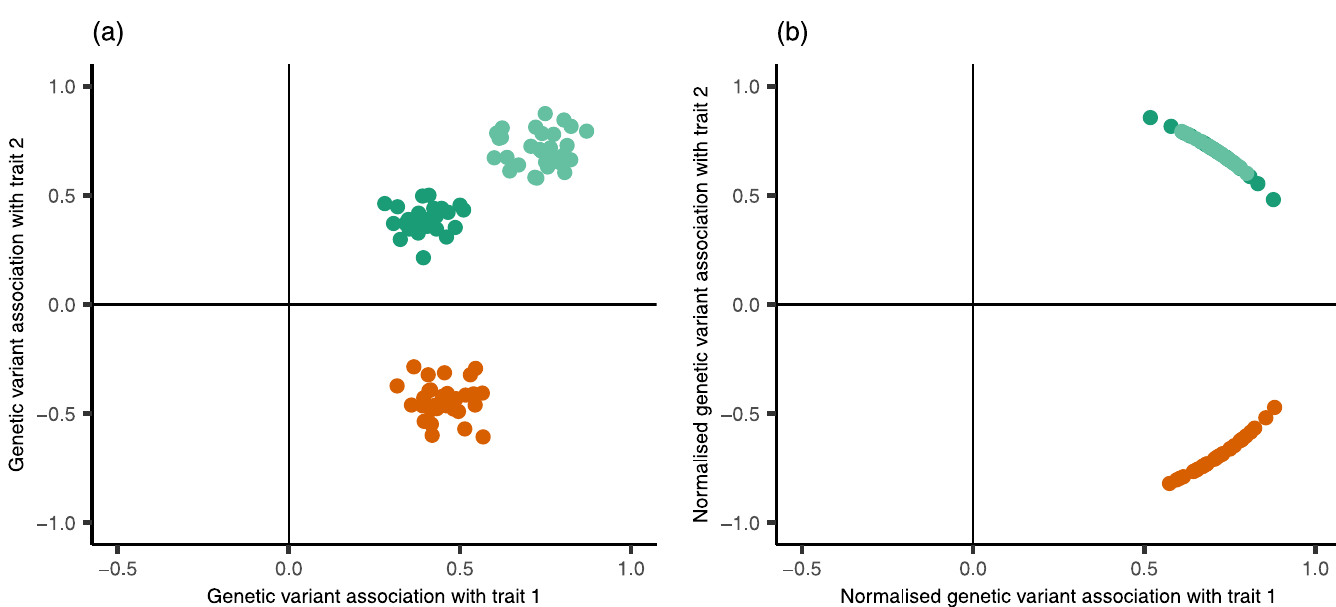
Fig 1. Illustrative figure showing the difference between clustering based on Euclidean distance compared with direction. Panel (a) plots 90 simulated points representing genetic associations with two traits. Each point was generated from one of three bivariate normal distributions. Panel (b) plots the normalised genetic associations, representing the proportional association of each genetic variant with respect to the two traits. All points sit on the unit circle. The green points represent genetic variants which are positively associated with each trait by similar magnitudes. The orange points represent genetic variants which are positively associated with trait 1 and negatively associated with trait 2, again by similar magnitudes. Methods based on Euclidean distance such as Gaussian mixture models and hierarchical clustering would consider there to be three clusters, distinguishing between the light and dark green points, as shown in Panel (a). Directional clustering approaches would consider there to be two clusters, grouping the green points in the same cluster. This is shown in Panel (b), where the points are clearly grouped in two separate clusters.